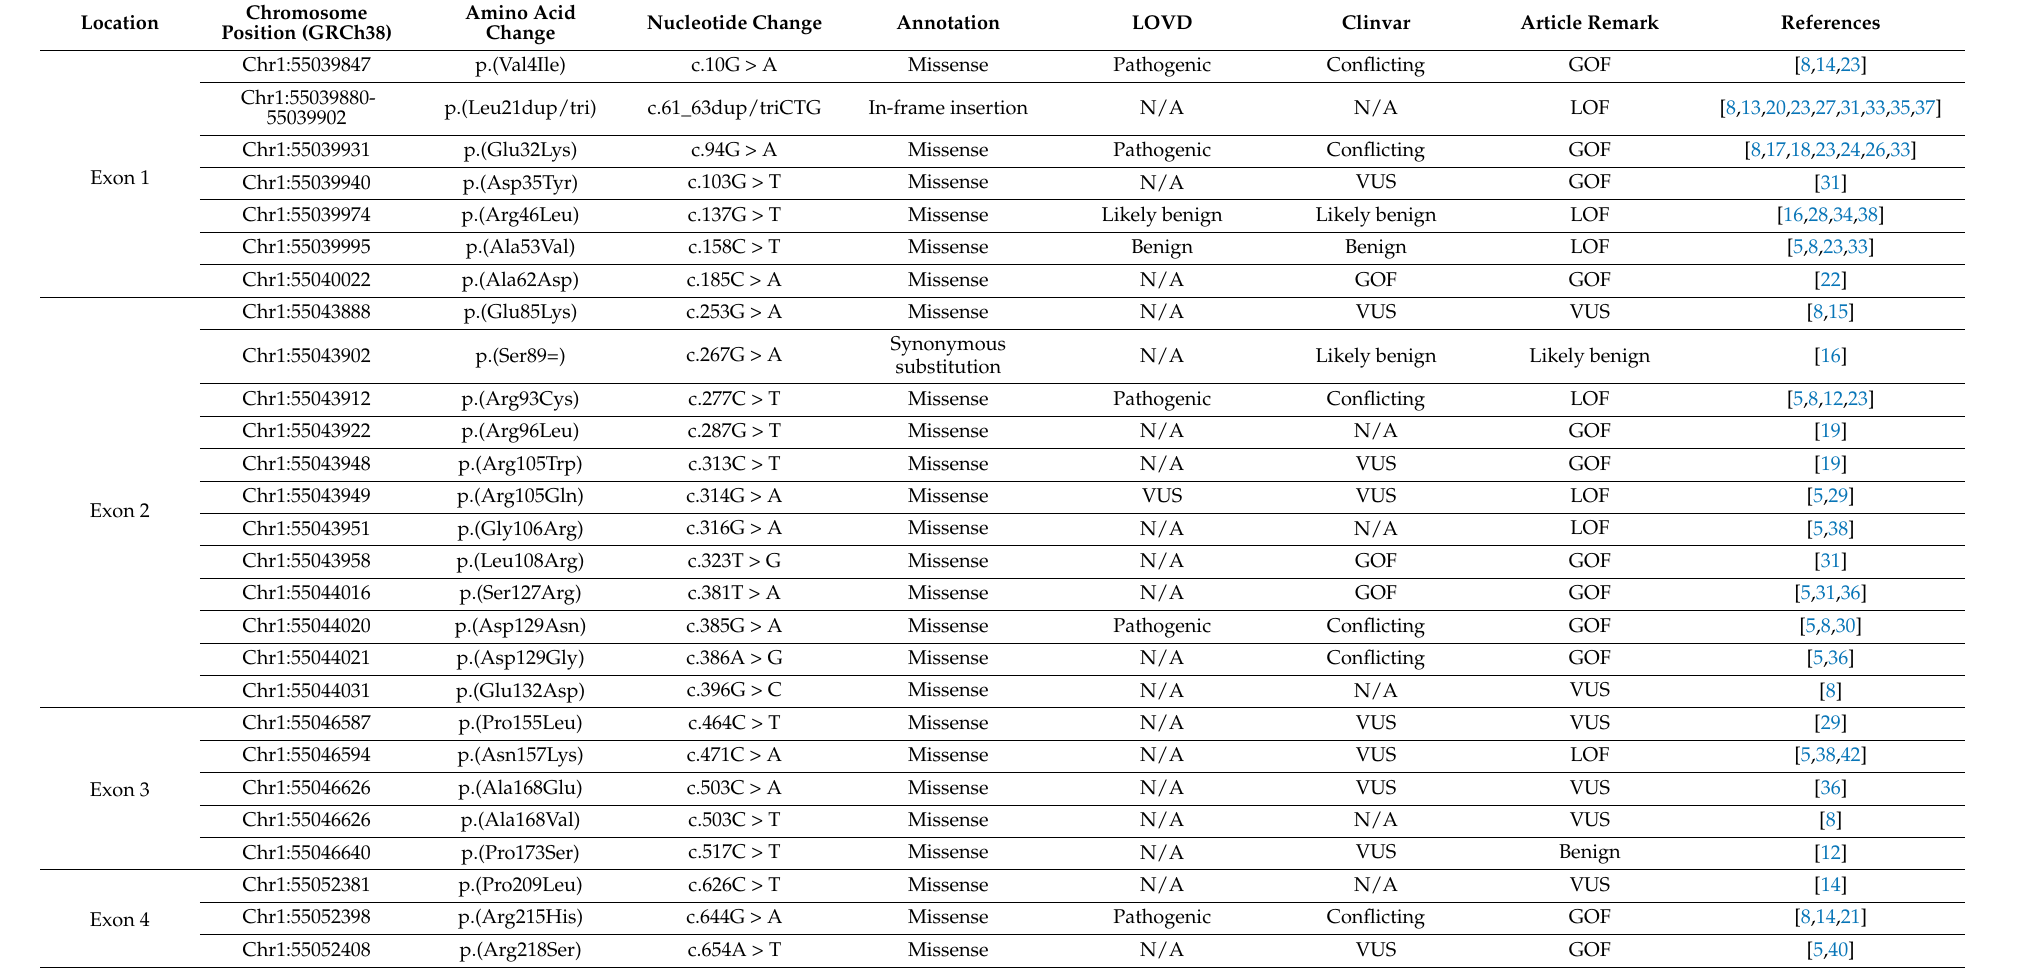
Table 3. List of 55 PCSK9 (gene and protein) variations and their